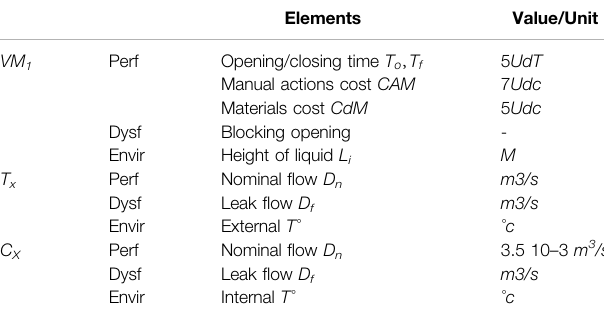
TABLE 3 | Health checkup